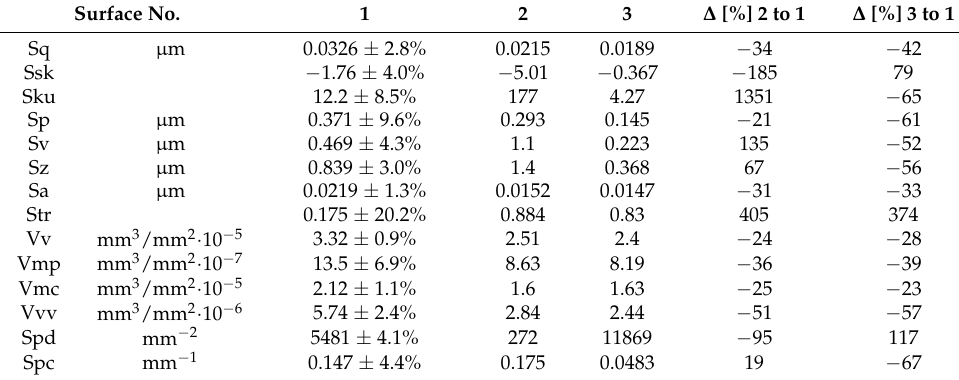
Table 1. Values of selected surface topography parameters of the base [20] and modified surfaces and changes of parameter values after